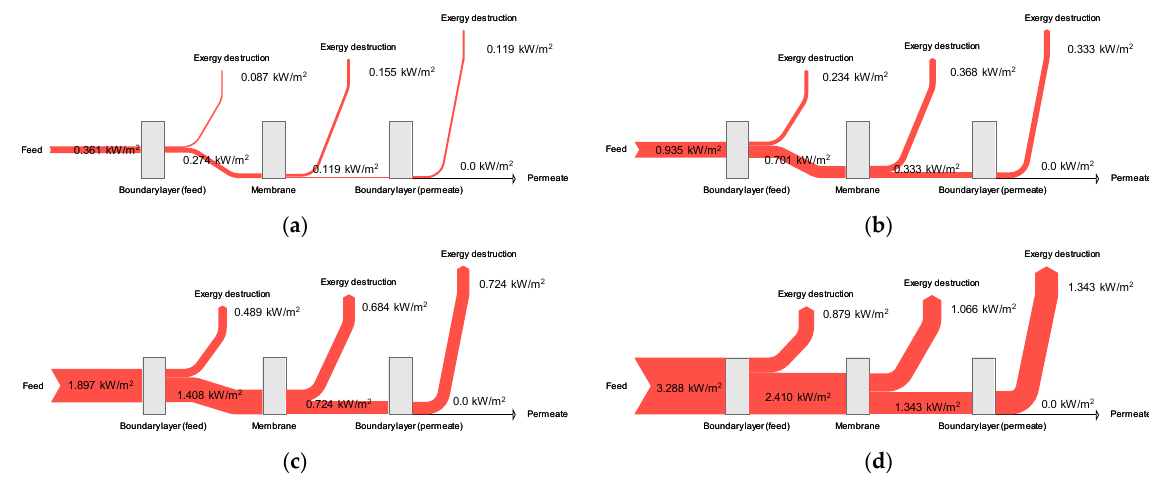
Figure 11. Exergy flow analysis for the DCMD module: ( a ) Feed temperature = 40 °C, feed flow rate = 0.6 L/min, and permeate flow rate = 0.4 L/min; ( b ) Feed temperature = 50 °C, feed flow rate = 0.6 L/min, and permeate flow rate = 0.4 L/min; ( c ) Feed temperature = 60 °C, feed flow rate = 0.6 L/min, and permeate flow rate = 0.4 L/min; ( d ) Feed temperature = 70 °C, feed flow rate = 0.6 L/min, and permeate flow rate = 0.4 L/min.